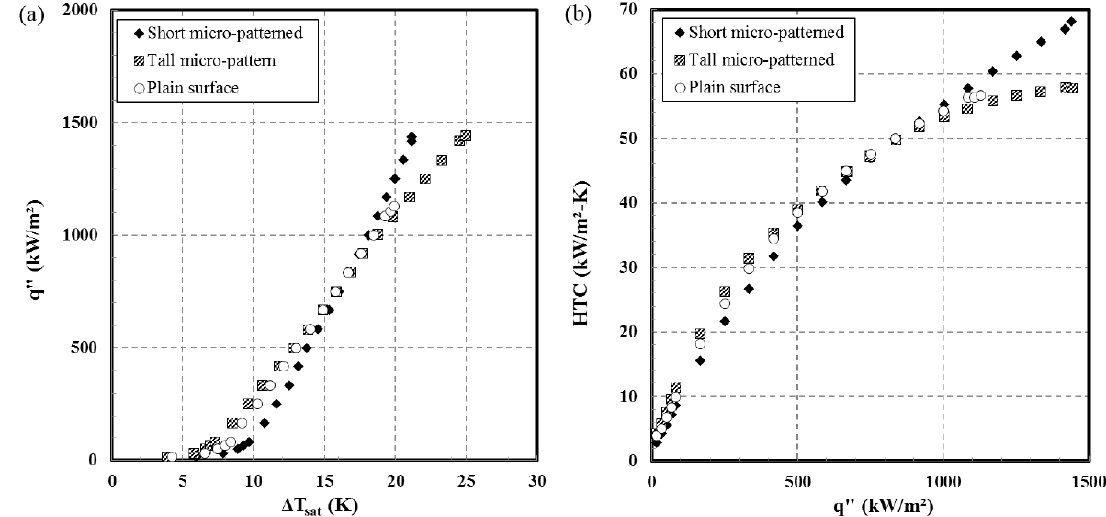
Figure 10. Boiling curves ( a ) and nucleate boiling heat-transfer coefficient ( b ) of the micro-patterned surfaces and plain surface.